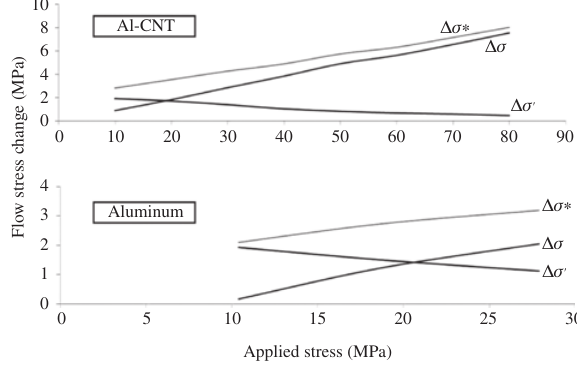
− σ ( t ), hardening com- o